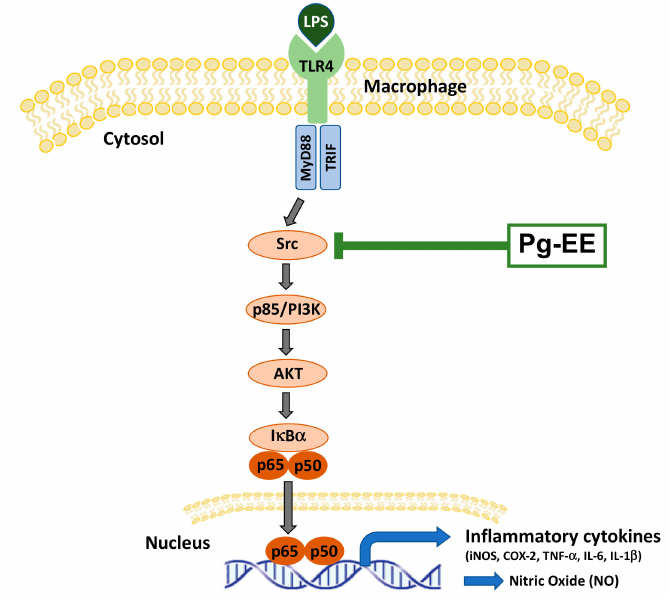
Figure 6. Scheme of the pathway of Pg-EE-mediated anti-inflammatory action. Pg-EE suppresses the phosphorylation of NF- κ B pathway components and translocation of p65 and p50 into the nucleus, leading to the inhibition of inflammatory responses. LPS, lipopolysaccharide; TLR4, toll-like receptor 4; MyD88, myeloid di ff erentiation factor 88; TRIF, toll-receptor associated activator of interferon; Pg-EE, Potentilla glabra var. mandshurica (Maxim.) Hand.-Mazz. ethanol extract; PI3K, phosphoinositide 3 kinase; I κ B α , inhibitor of κ B α